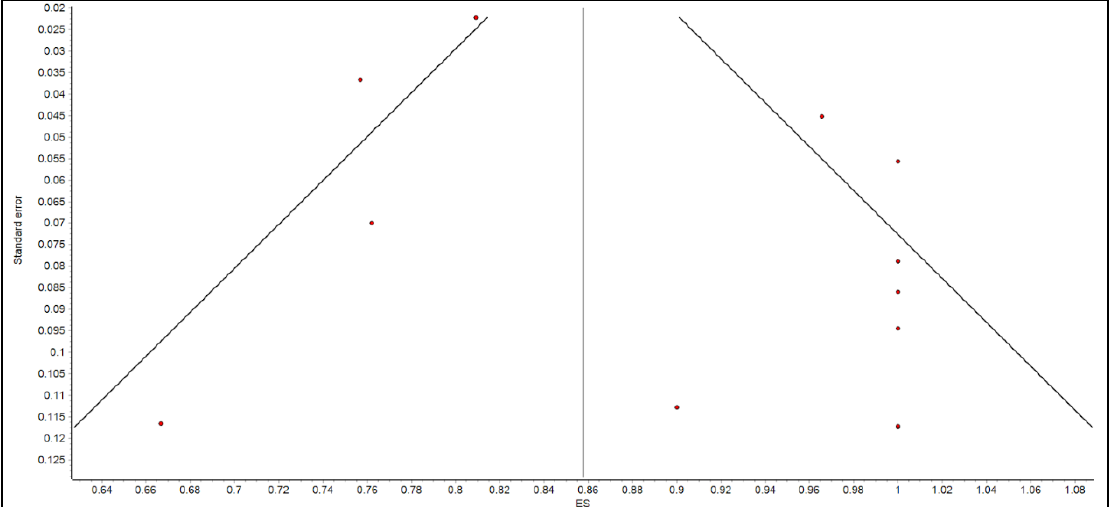
Figure 6. Funnel plot for assessing the evidence of publication bias .